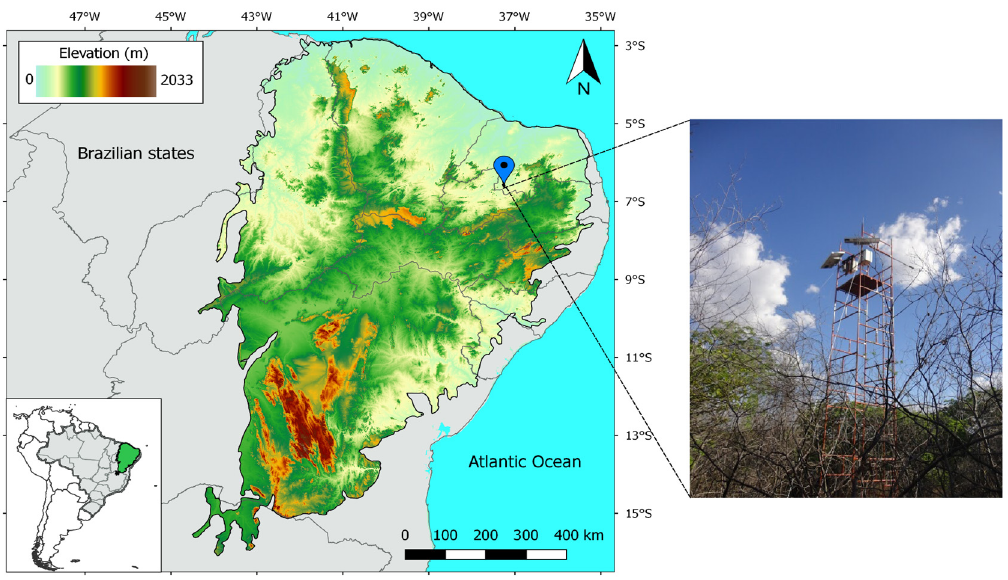
Figure 1. Location of the Caatinga biome and topography map with Brazilian states division and the location of the micrometeorological tower installed in the ESEC-Seridó, Brazil.